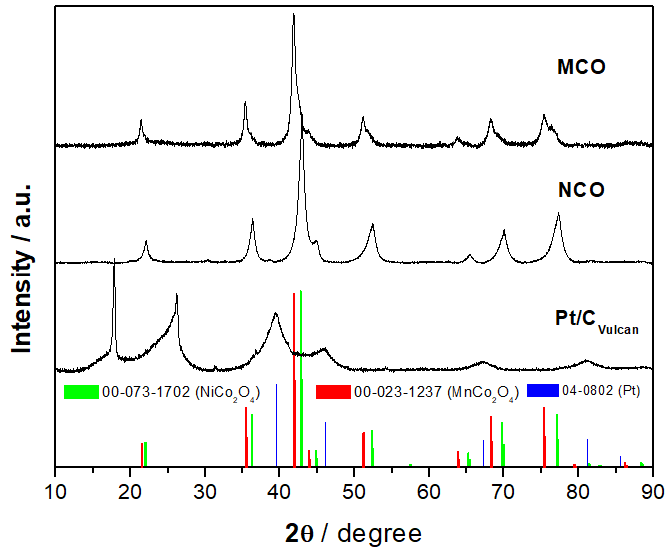
Figure 2. XRD patterns of as-prepared NiCo 2 O 4 and MnCo 2 O 4 as well as Pt / C powder from a commercial GDE.